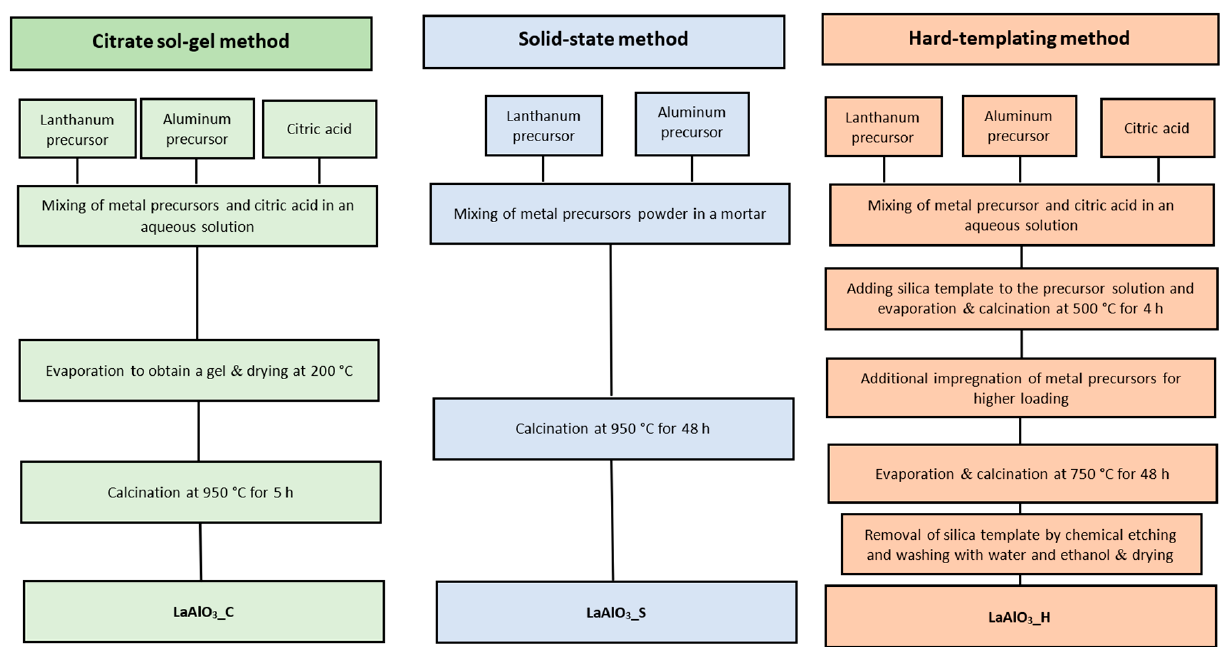
Figure 17. Schematic representation of the preparation methods for obtaining LaAlO 3 perovskite catalysts (Reprinted with permission from [69]).